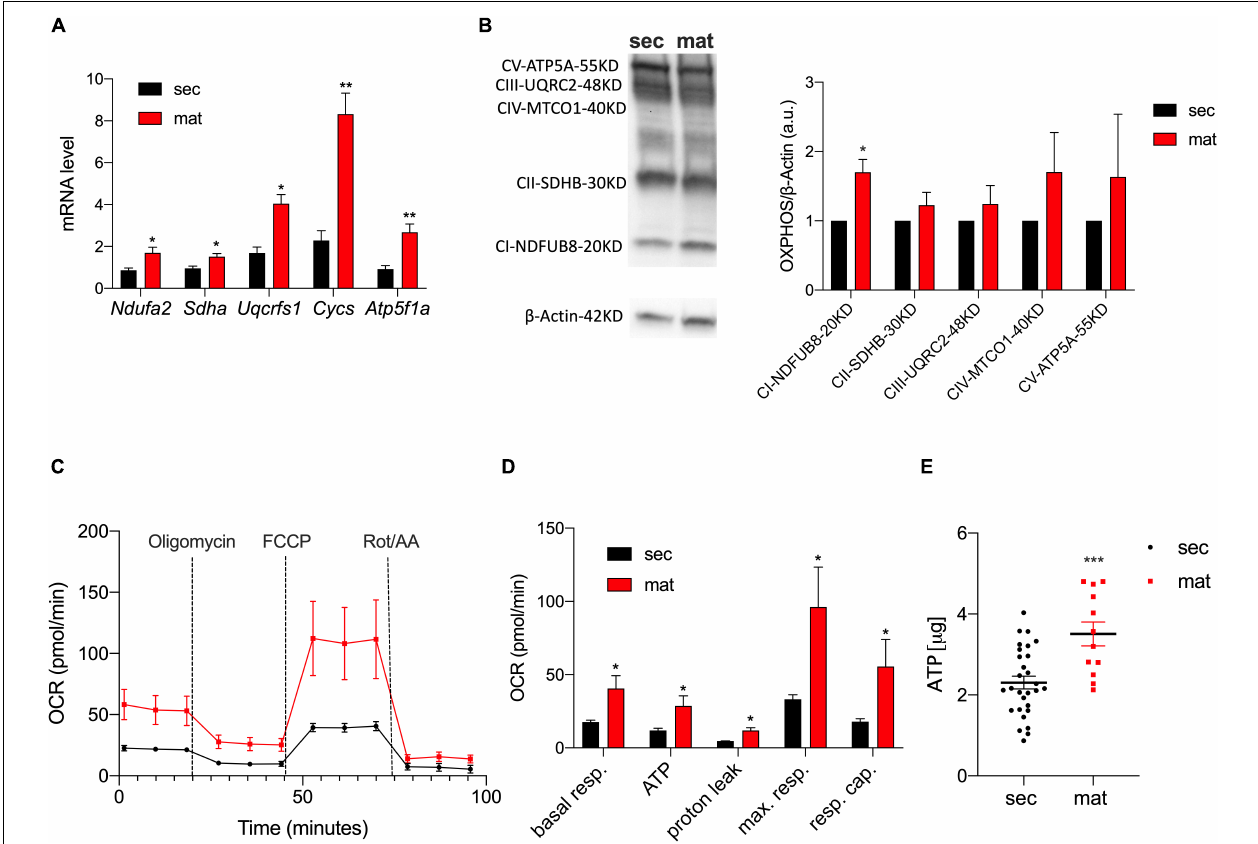
FIGURE 2 | Mitochondrial respiration and ATP production are upregulated in maturation. (A) RT-qPCR analyses of components of the ETC subunits [NADH ubiquinone oxidoreductase subunit A2 (Complex I – Ndufa2), succinate dehydrogenase complex flavoprotein subunit A (Complex II – Sdha), ubiquinolcytochrome c reductase, Rieske iron-sulfur polypeptide 1 (Complex III – Uqcrfs1), cytochrome c, somatic (Cycs) ATP synthase F1 subunit alpha (Atp5f1a)]. (B) Western blot and ImageJ analyses of complexes CI-NDUFB8, CII-SDHB, CIII-UQCRC2, CIV-MTCO1, and CV-ATP5A show higher expression in maturation (C) . OCR traces (and respective quantification in (D) in secretory and maturation EO cells showed an overall increase in OXPHOS in the latter, with a significant increase in ATP production. (E) Higher ATP levels in maturation cells measured by luminescence. Data represent mean ± SEM from at least n = 3–6 (* P < 0.05, ** P < 0.005, *** P < 0.001, two tailed unpaired Student’s t